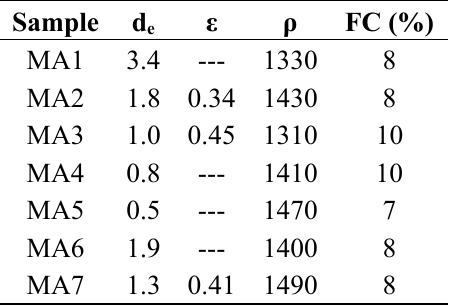
Table 2. The main physical characteristics of soils used in the column experiments. Sample